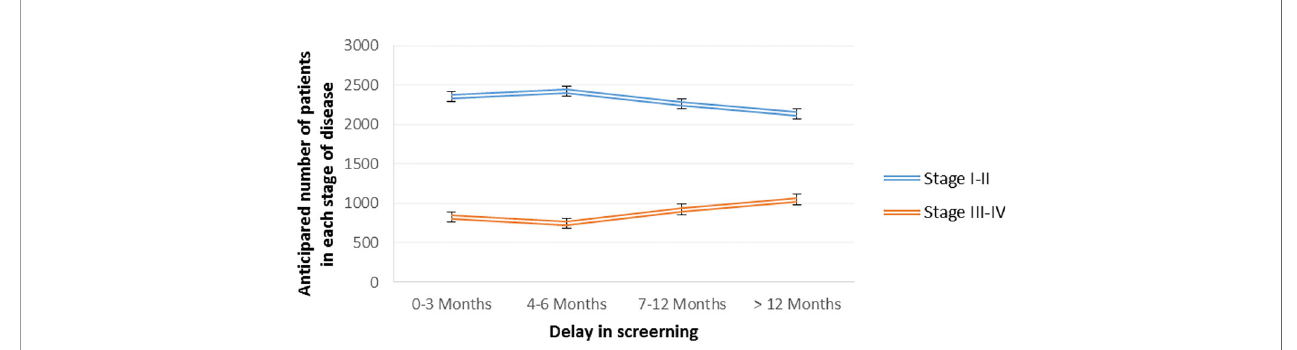
FIGURE 2 | Estimated colorectal cancer progression due to delayed diagnosis in various intervals, based on Ricciardiello et al.